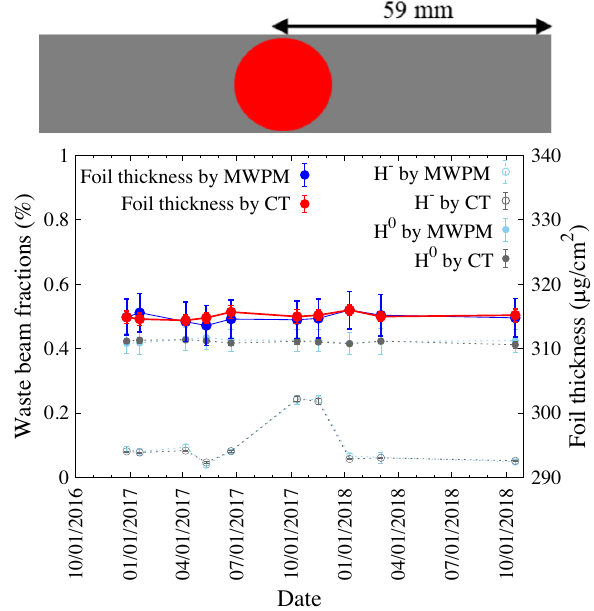
FIG. 15. Measurement of the foil degradation at 59 mm far from the foil edge, where ideally no particles hit the foil in usual operation. Unlike the measured foil degradations due to high- intensity beam irradiation at 9 mm far from the foil edge (Fig. 12), there occurred no foil degradation at a position where no beam irradiation on the foil usually took